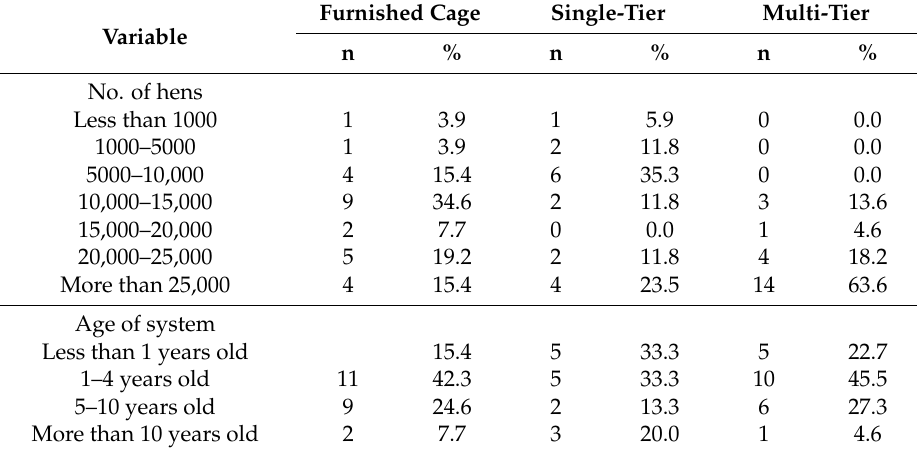
Table 1. A description of general farm characteristics for 65 laying hen flocks placed between October 2016 and December 2017 according to housing system (furnished cage n = 26, single-tier n = 17, multi-tier n = 22) in